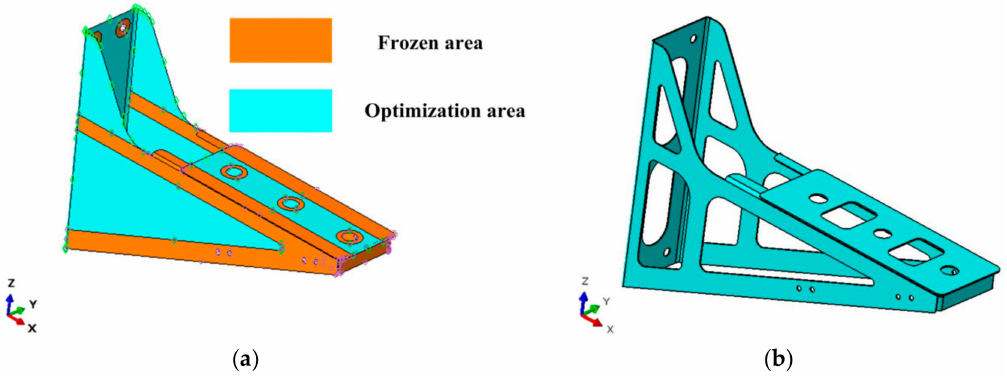
Figure 3. Seat bracket before optimization ( a ) and ( b ) after optimization.